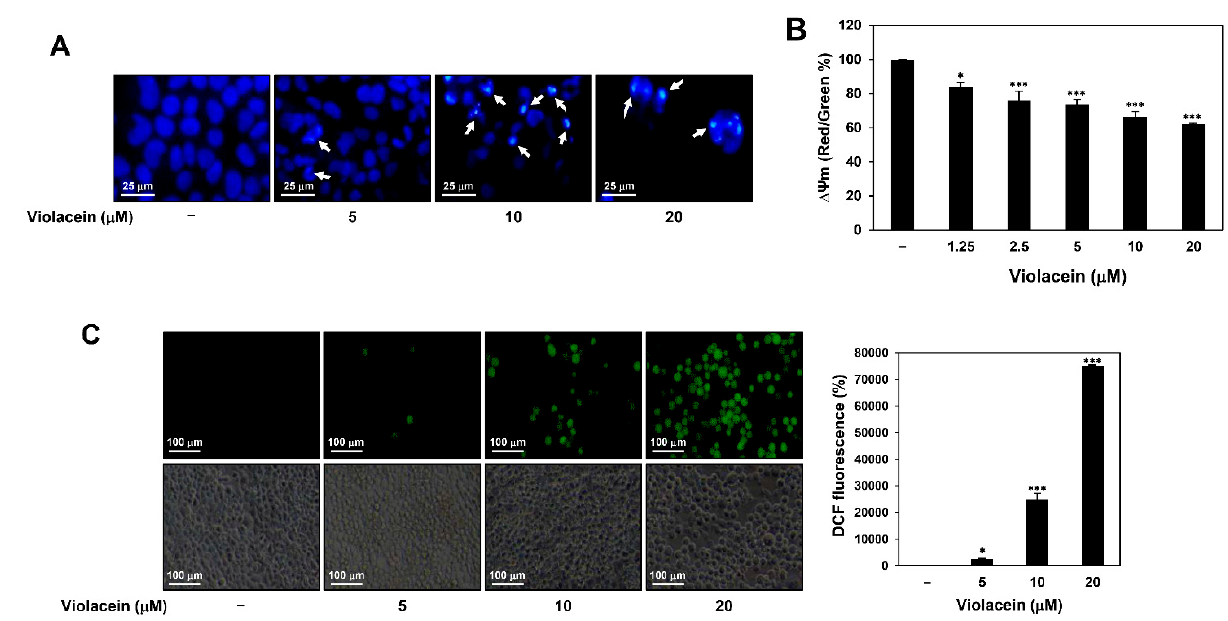
Figure 2. Violacein promotes apoptotic characteristics in Huh7 HCC cells. ( A ) Effect of violacein on the nuclear morphology. Huh7 cells were treated with violacein (5, 10, and 20 µM) for 24 h. Changes in nuclear morphology were monitored by DAPI staining under a fluorescence microscope. The condensed nuclei are indicated by white arrows. ( B ) Effect of violacein on the MMP. Huh7 cells were treated with violacein (0 − 20 µM) for 24 h and stained with JC-1. The fluorescence intensity of J-aggregates and JC-1 monomers was detected by a multimode microplate reader. ( C ) Effect of violacein on the generation of intracellular ROS. Huh7 cells were treated with violacein (5, 10, and 20 µM) for 6 h. The levels of ROS were detected with DCFH-DA using a fluorescence microscope and were further quantified by densitometry. ∗ p < 0.05, ∗∗∗ p < 0.001 vs. the control.